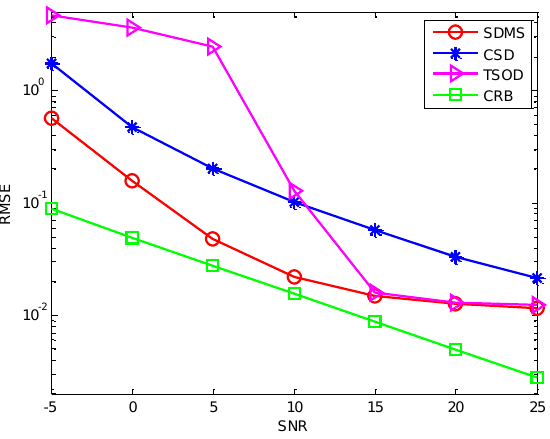
Figure 4. Performance versus SNR in the white noise condition.